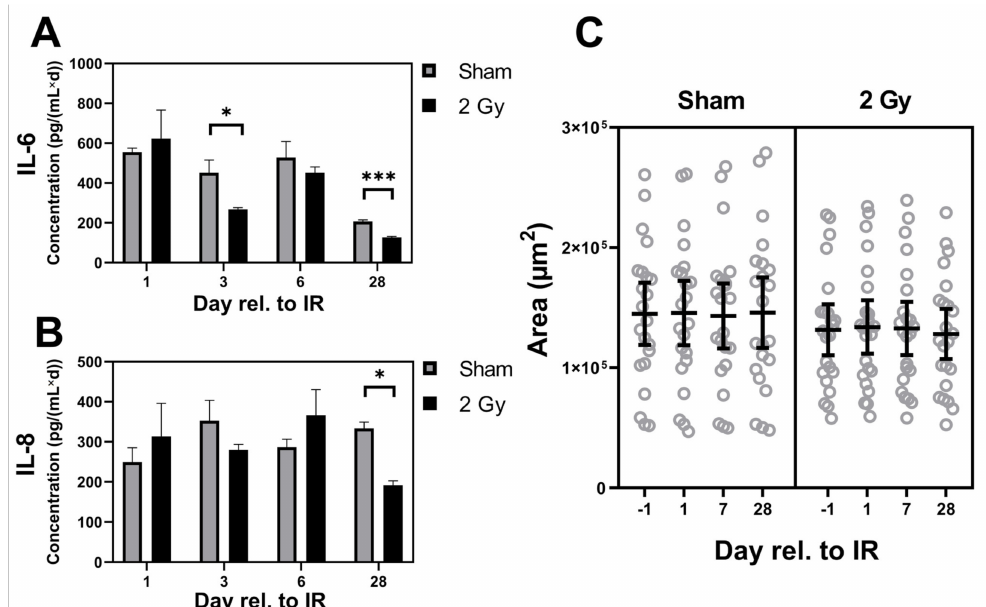
Figure 7. X-ray irradiation (2 Gy) does not trigger excess interleukin secretion or hypertrophic morphology in hPSC-CMC. ( A , B ) Secretion of IL-6 and IL-8 1, 3, 6, and 28 days after exposure of hPSC-CMC cultures (n = 6, pooled for analysis) to 2 Gy of X-rays. Data were normalized to a cultivation time of 3 days in the supernatant and shown as mean ± SD. * p ≤ 0.05, *** p ≤ 0.001 using two-sided t -test. ( C ) Area of individual hPSC-CMC (circles, n = 22–23) 1 day prior and 1, 7, and 28 days post irradiation with 2 Gy of X-rays. Data shows the mean ± 95%